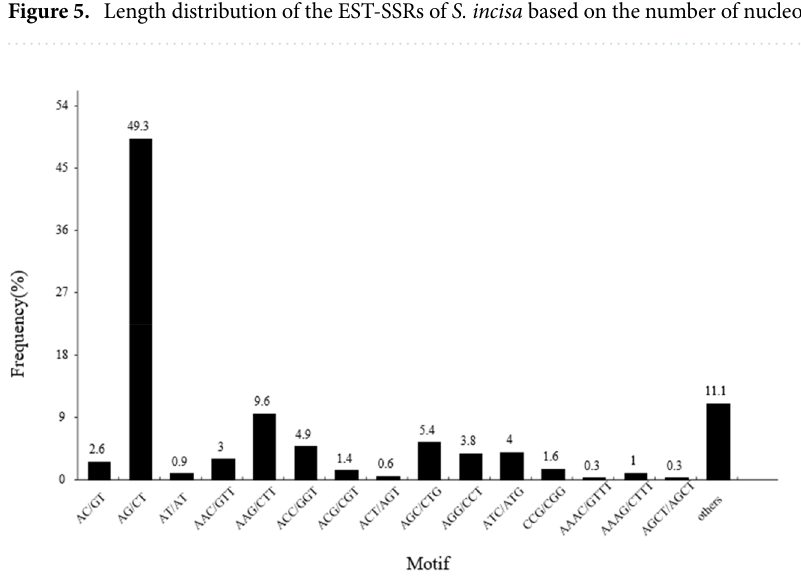
Figure 6. Distribution of SSR